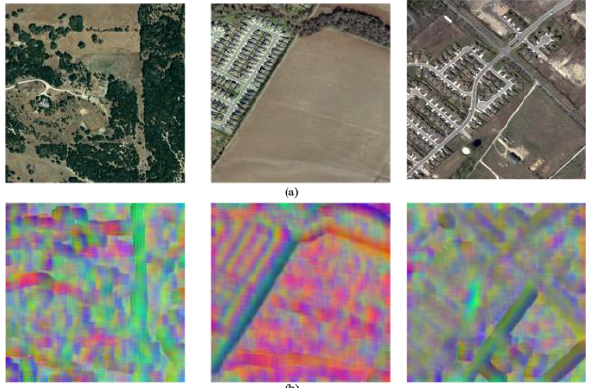
Figure 5. Visualisation of SIFT images. (a) example images. (b) corresponding SIFT image visualization.